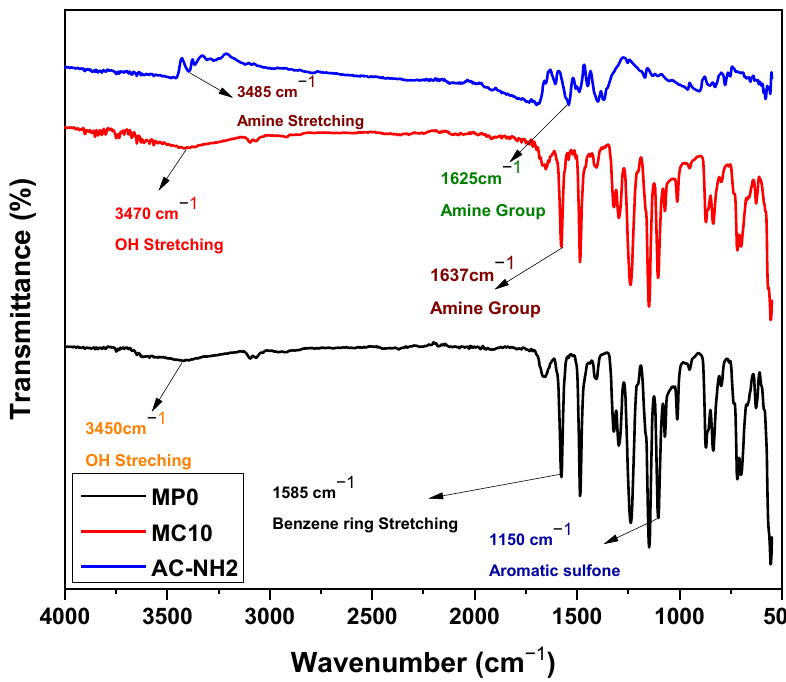
Figure 7. FTIR of MP0 Pristine PES, MP10 PES with AC, Modified AC.